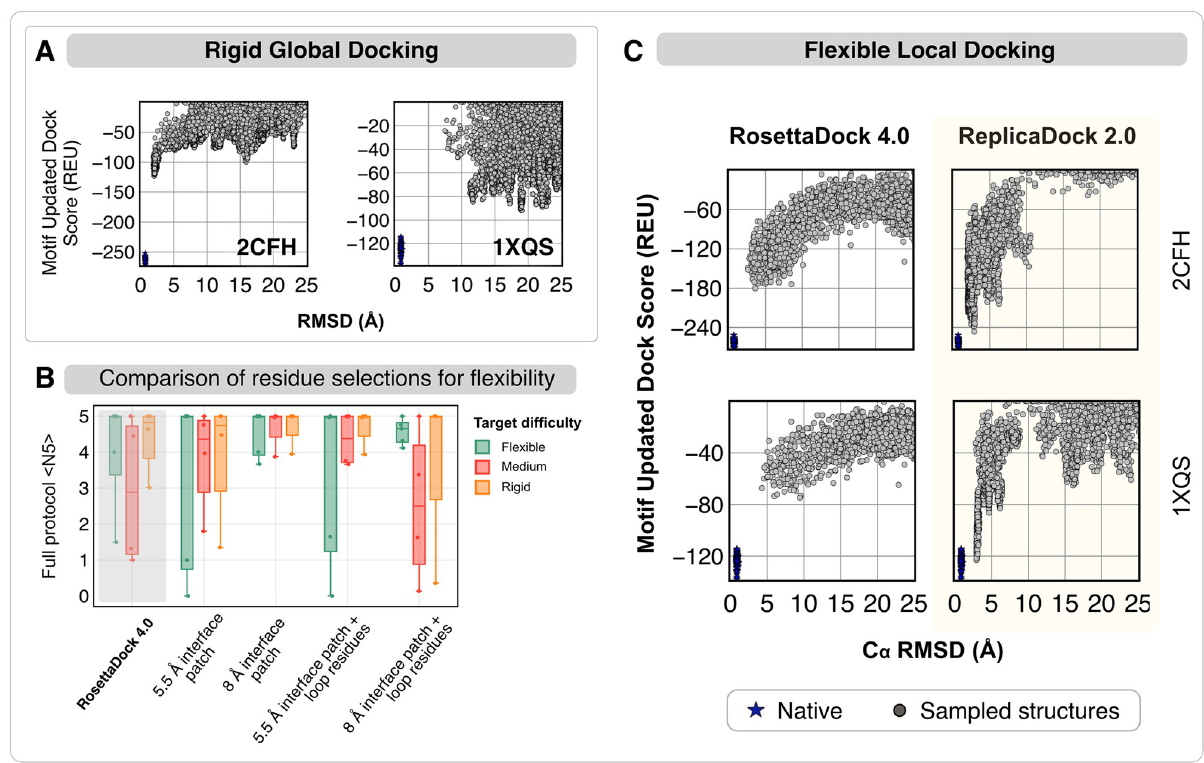
Fig 2. T-REMC improves low-resolution performance in global rigid-body and local flexible docking for two representative protein targets. (A) Global rigid-body docking performance for protein targets 2CFH (trafficking protein particle complex subunits) [37] and 1XQS (HspB1 core domain complexed with Hsp70 ATPase domain) [38]. Plots show the Motif Updated Dock Score (REU) vs all-atom C α rmsd ( Å ). Blue points denote the refined native structures. (B) Comparison of different residue selections for performing backbone moves. Performance of ReplicaDock 2.0 with four conditions: (1) 5.5 Å interface patch, (2) 8 Å interface patch (3) 5.5 Å interface patch + loops, (4) 8 Å interface patch + loops. The metric is h N5 i , the average number of near-native models in the five top-scoring structures. For reference, RosettaDock 4.0 performance is highlighted in gray. (C) Local flexible backbone docking performance. Motif Updated Dock Score (REU) vs C α rmsd ( Å ) for two targets, 2CFH [37] and 1XQS [38]. Panels show * 5,000 decoys generated by RosettaDock 4.0 (left) and ReplicaDock 2.0 (right, this work).